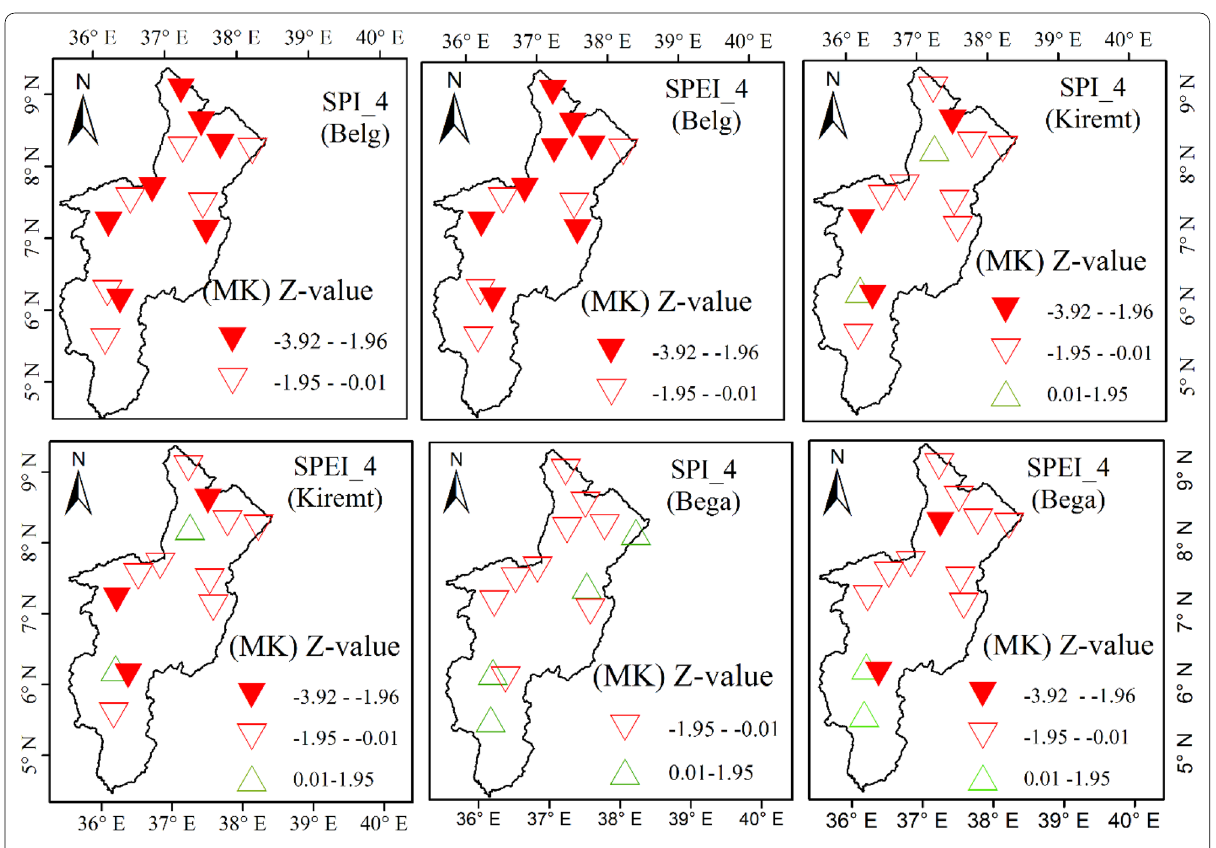
Fig. 6 Spatial patterns of the changing trend of seasonal drought severity based on the SPI-04 and SPEI-04 time-series detected by the Mann– Kendall test. The solid downward red triangle denotes the increasing trend of dryness((SS) Statistically Significant at the 95% confidence level), the red hallow downward triangle denotes ((NS) Not-Significant) increasing trend of dryness, and the green hallow upward triangle denotes ((NS) Not-Significant) increasing trend of